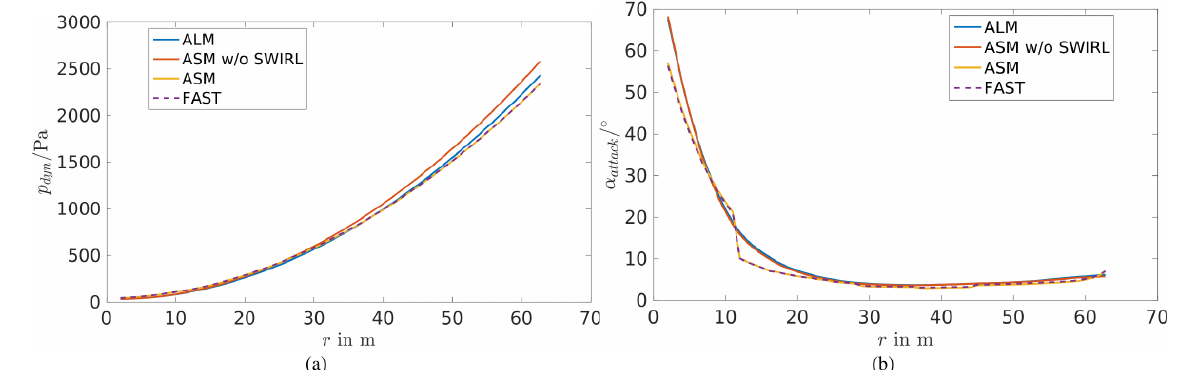
Figure A1. Dynamic pressure (a) and angle of attack (b) along the blade nodes in the laminar case of the NREL 5MW turbine.